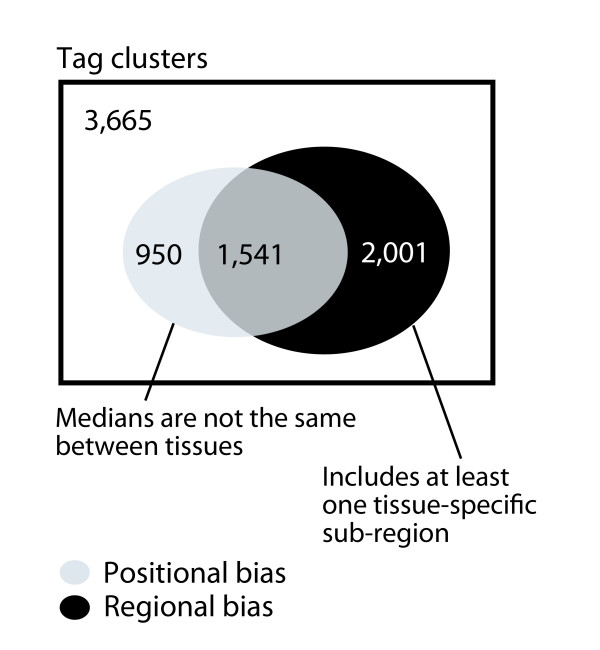
Tag clusters classified as positional and regional biases. The Venn diagram shows the number of tag clusters where start site selection is biased due to tissue. A biased tag cluster can either have distinct medians for tag starts for different tissues (termed positional bias) and/or have subregions that have a significantly different tag composition than the whole tag cluster. Most tag clusters that have positional bias also have subregions with significantly different tag composition. Only the tag clusters that are not classified as positional bias but include tissue-specific subregions are termed regional biases.